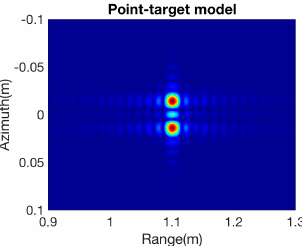
Figure 7. Image of two targets based on the point-target model.